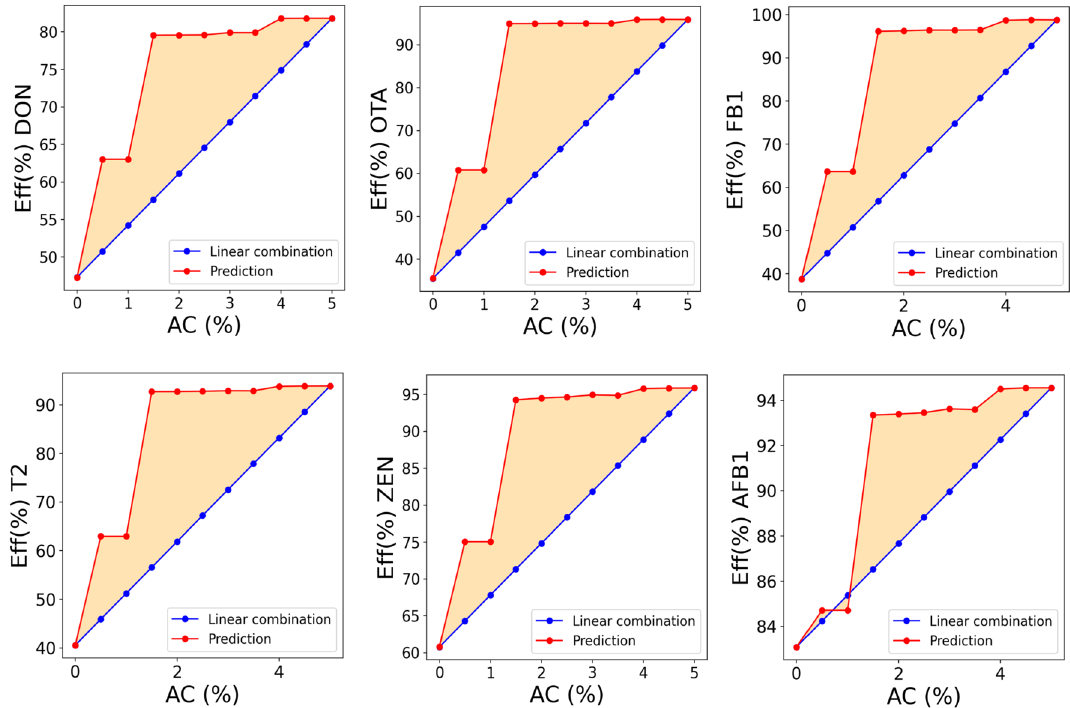
Figure 4. Synergy capturing by RF predicting efficiency for a series of hybrids of sepiolite-montmorillonite- charcoal in which the sepiolite-montmorillonite ratio was fixed to 1/4. The orange area is assigned to the positive synergistic effect. The experimental settings for the uptake of DON, OTA, T2, FB1 and ZEN were fixed to 2 kg/t of inclusion rate of MDT, 2 µg/ml of toxin concentration. The pH during the adsorption experiment was fixed to 3 while the desorption pH was